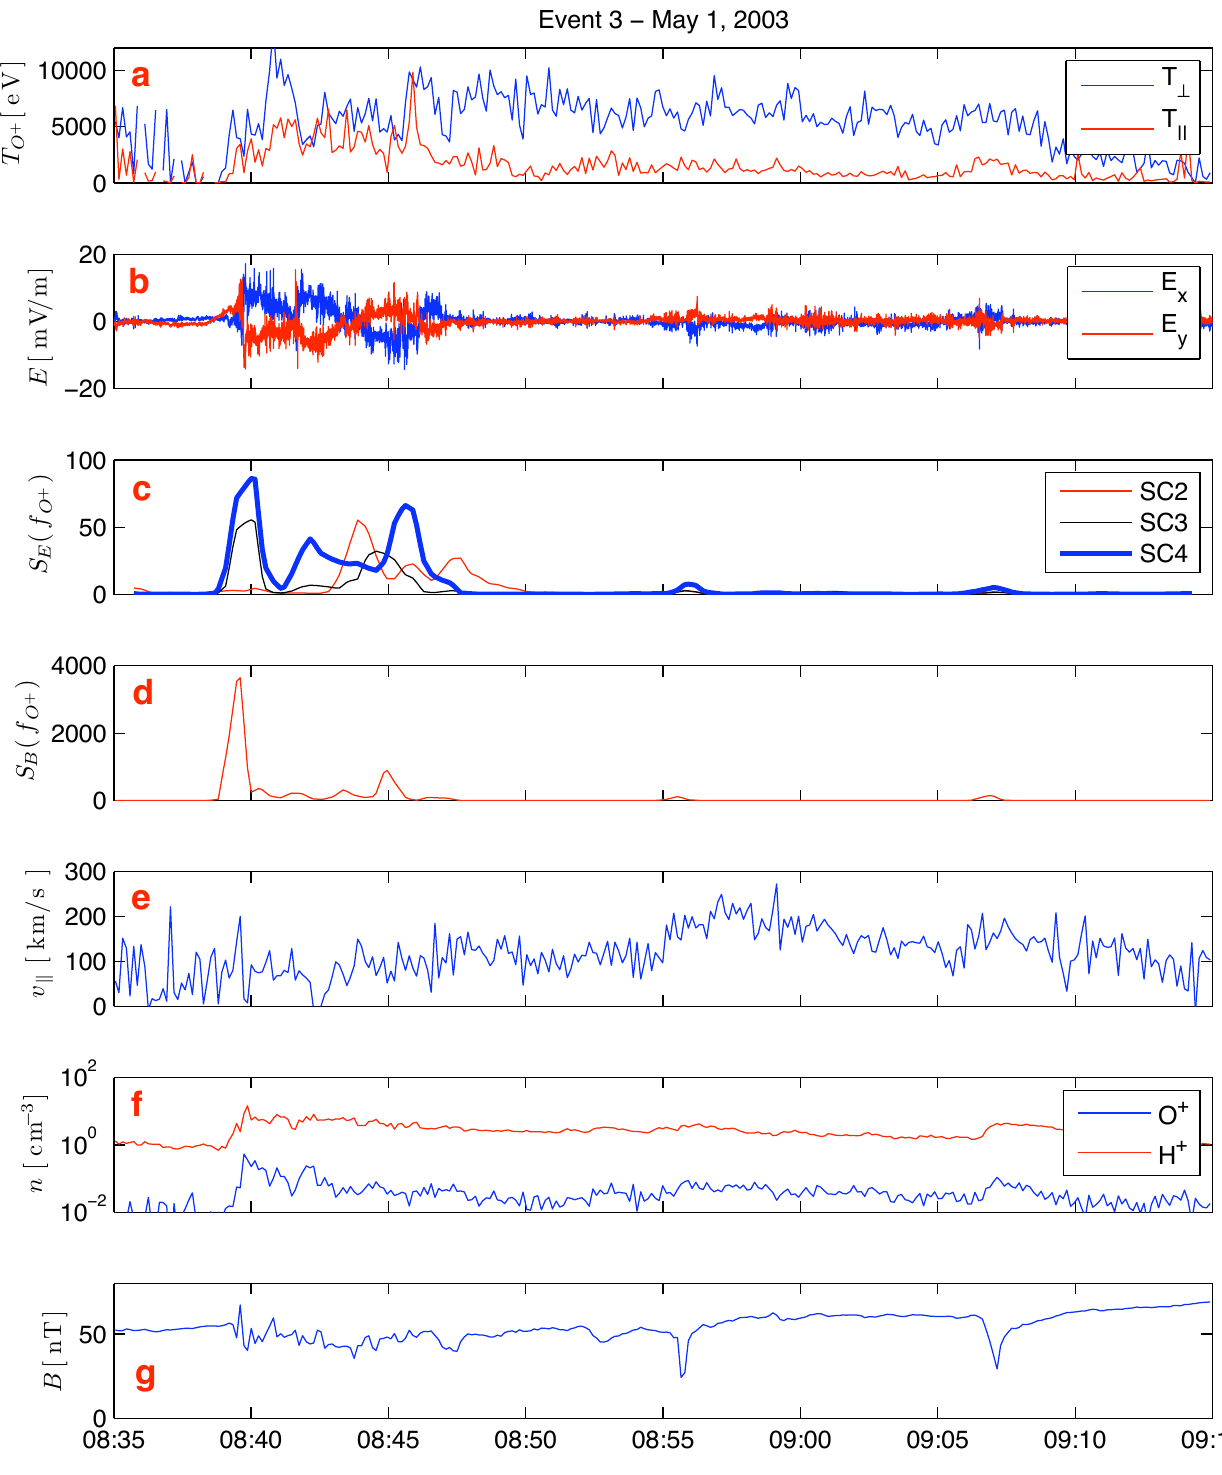
Fig. 6. SC4 measurements for Event 3 (1 May 2003): Panel (a) shows the perpendicular (blue) and the parallel (red) O + temperatures, panel (b) the electric field for the two components measured in the satellite spin plane, panel (c) the power spectral density at f O + for the electric field given in (mVm − 1 ) 2 Hz − 1 measured by different spacecraft (the blue line corresponds to SC4), panel (d) the power spectral density at f O + for the magnetic field given in (nT) 2 Hz − 1 , panel (e) shows the O + parallel velocity, where the outflow direction is defined to be positive, panel (f) the number densities for O + (blue) and H + (red), and panel (g) the magnitude of the background magnetic